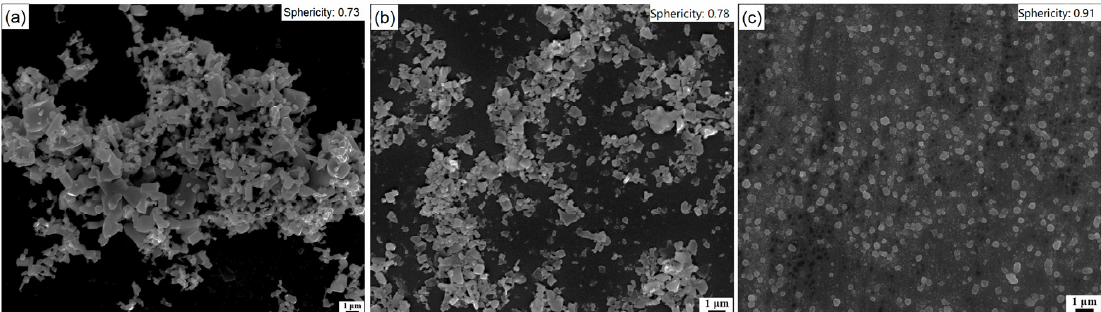
Figure 2. SEM pictures of zinc oxide particles: ( a ) feed; ( b ) ground for 30 min in water; ( c ) ground for 30 min in CH 3 COOH solution at a low concentration of 0.010 mol/L.